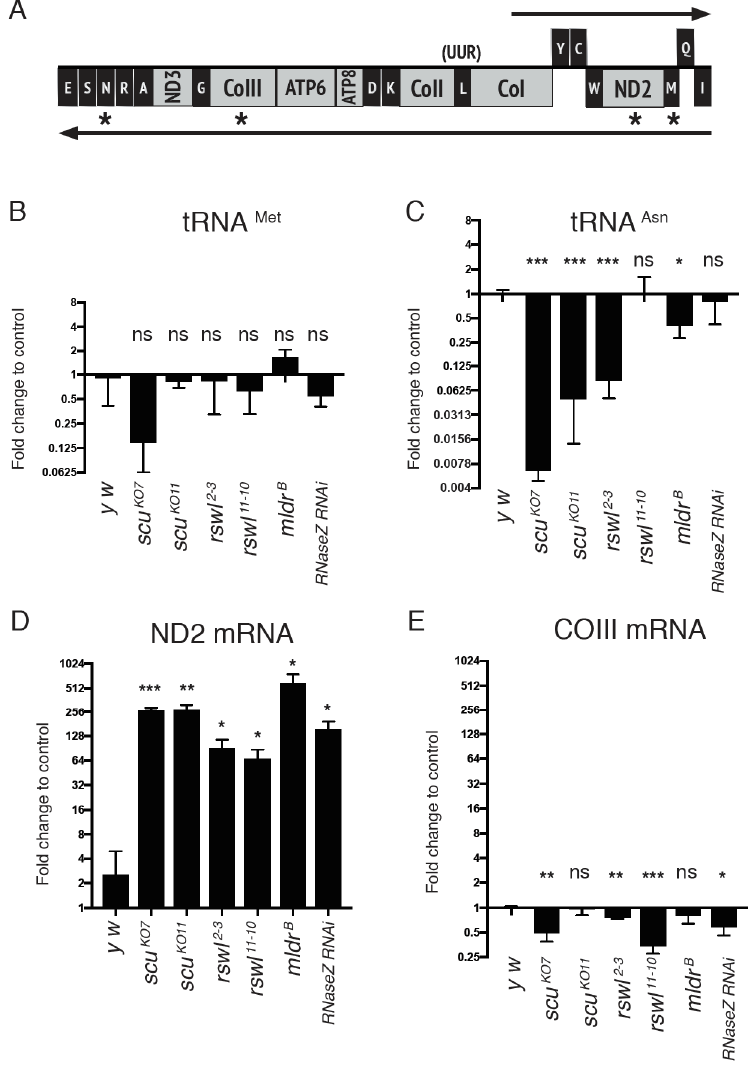
Figure 5. Steady state levels of mt:tRNAs and mt:mRNAs in mtRNase P mutants. ( A ) Graph of the analyzed mtRNA species (asterisks) located on the same polycistronic transcript. The graphs represent the log 2 fold change in the steady-state amounts of mt:tRNA Met ( B ), mt:tRNA Asn ( C ), ND2 mRNA ( D ), and COIII mRNA ( E ) in scu , rswl , mldr , and RNaseZ RNAi mutants. Bars on the graphs represent averaged 2ˆddCt, and the y-axis is log 2 . Further explanation can be found in the materials and methods. Error bars: S.E.M. calculated in GraphPad PRISM. p -values were calculated using GraphPad PRISM using an unpaired t -test, two-tailed, and compared each mutant to the y w control. * p < 0.05; ** p < 0.01; *** p < 0.001; ns: not significant.